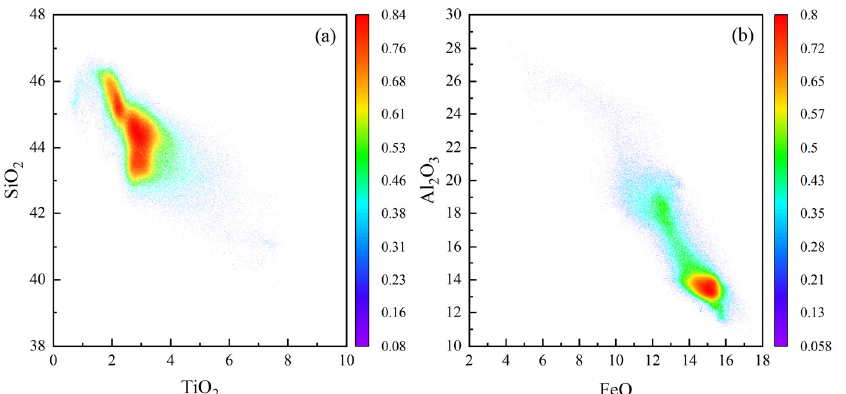
Figure 18. ( a ) Two-dimensional density plot between IIM FeO and IIM Al 2 O 3 and ( b ) Two-dimen-